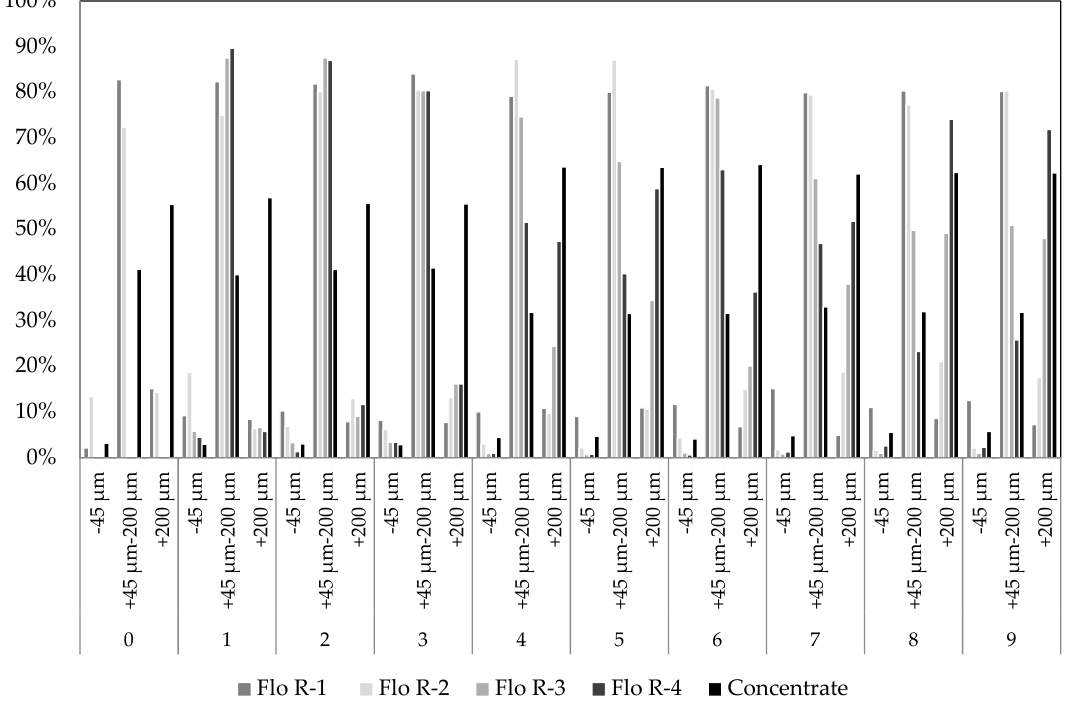
Figure 3. Particle size distribution in three distinct fractions.